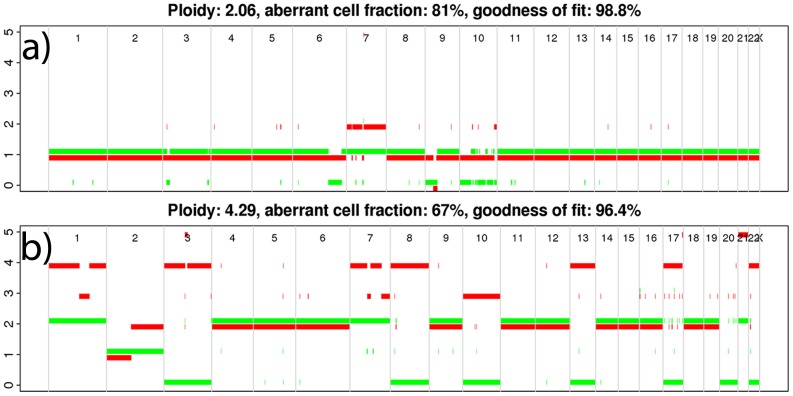
ASCAT-profiles.Whole genome ASCAT-profiles from two samples in the UMU dataset; one diploid (a) and one tetraploid (b). Green represents the allele with the lower copy number, and red represents the allele with the higher copy number (the colors are slightly offsetted to avoid overlap, red downwards and green upwards).